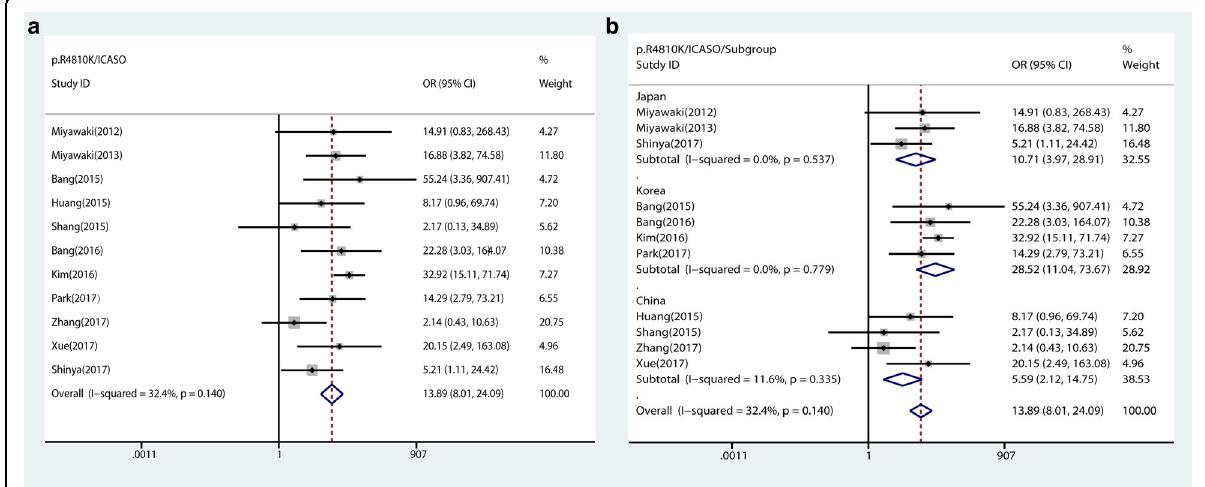
Fig. 4 Forest plots for the association of RNF213 p.R4810K with ICASO under the dominant model. a Forest plots of RNF213 p.R4810K and ICASO in the general population under the dominant model. b Forest plots of RNF213 p.R4810K and ICASO in the subgroup populations under